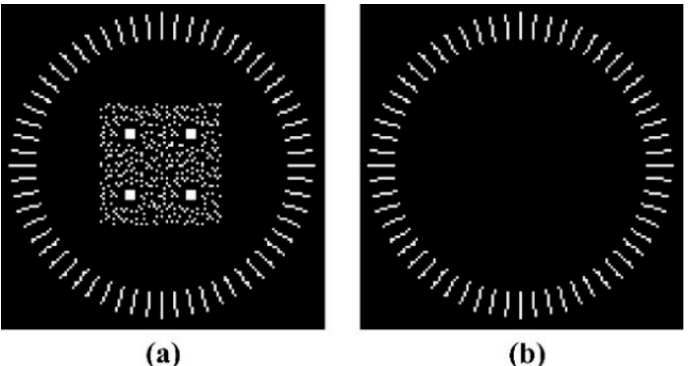
Figure 3. ( a ) The reference light pattern and the signal light pattern uploaded on the SLM; ( b ) the reference light pattern, which is also the reading light pattern.